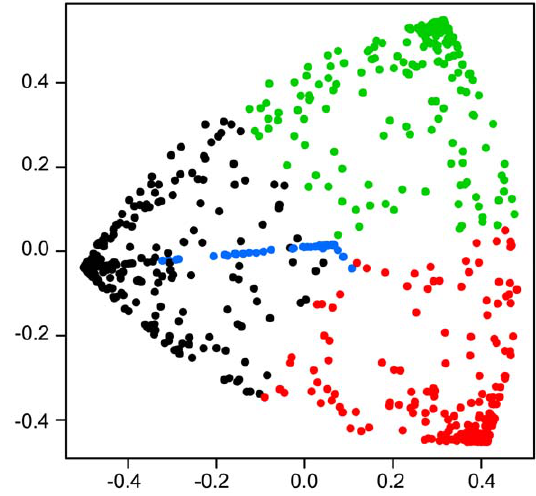
Figure 3. Multidimensional scaling representation of 1072 core genes. Similarity between pairs of genes is measured as the probability that two genes share the same topology. Genes are colored according to their most probable topology, with black referring to topology 1, red is topology 2, and green topology 3; blue refers to other rare topologies (see Table 2 for topology descriptions).